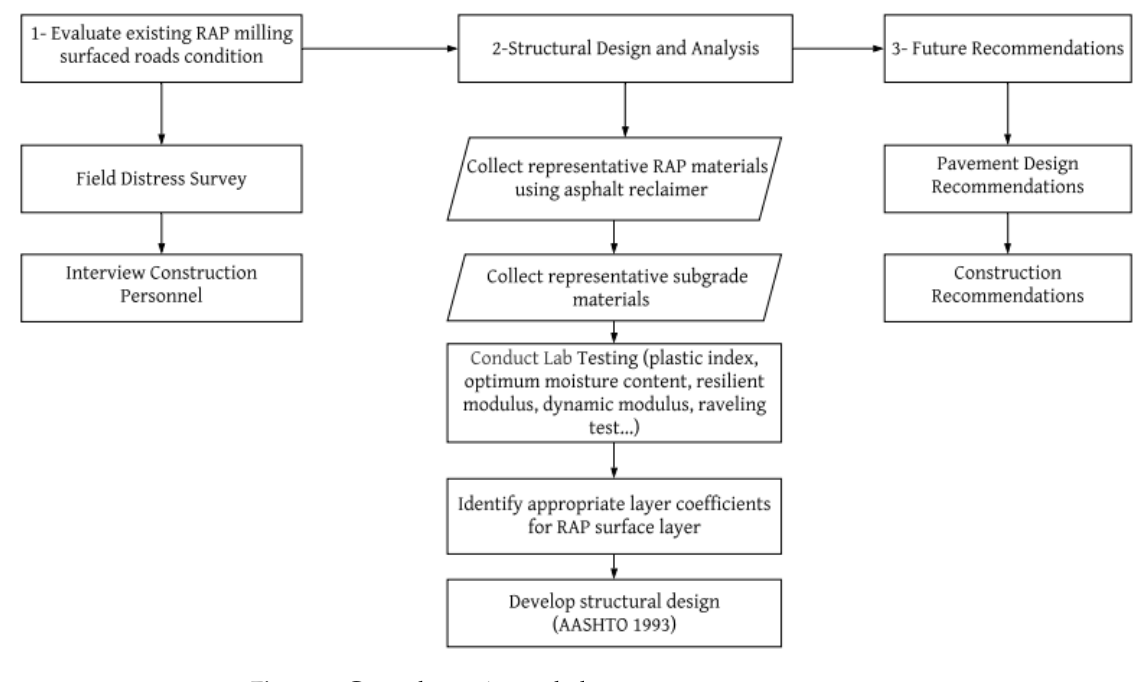
Figure 2. General experimental plan.